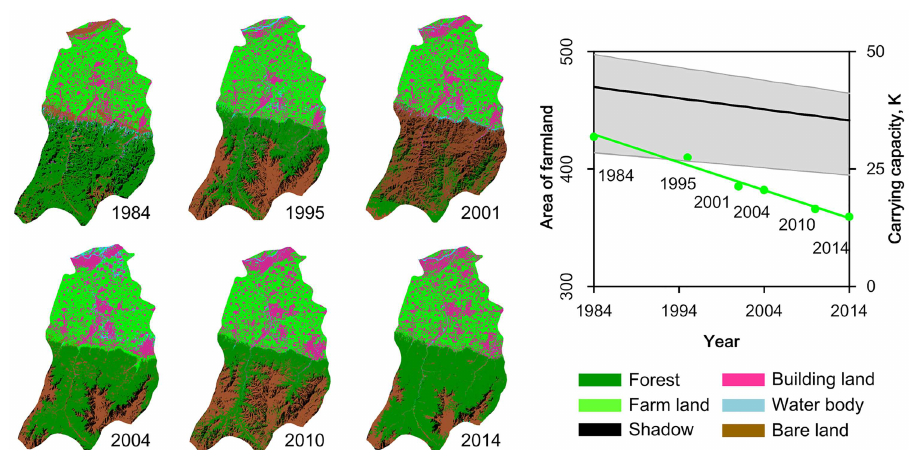
Fig 4. Farmland loss and estimated carrying capacity in Hu County, 1984–2014. Left panel: Land cover maps of Hu County were producedusing supervisedmaximum-likelihoodclassifications of Landsat Thematic Mapperdata. Time series Landsatsatelliteimages, covering the entire city area of Hu County, were used to detect land cover changes,includingforest, farmland, buildingland, bare land, and water. Right panel: Area of farmland(green point) was obtained from remote sensingimages, time-varying carrying capacity was estimated from Eq 2. The green line shows the linear regressionof farmlandarea over time, and the black line represents the estimated carryingcapacity, and the grey area indicates the 95%